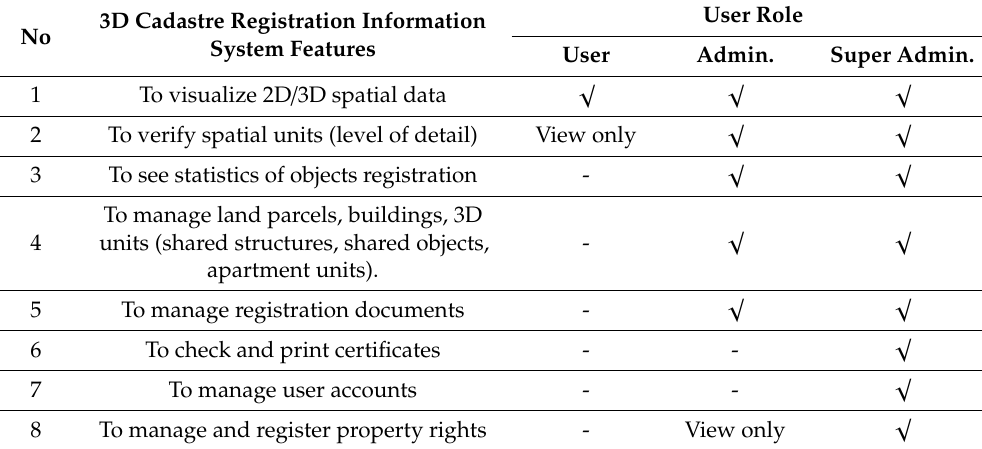
Table 3. Functions and corresponding user